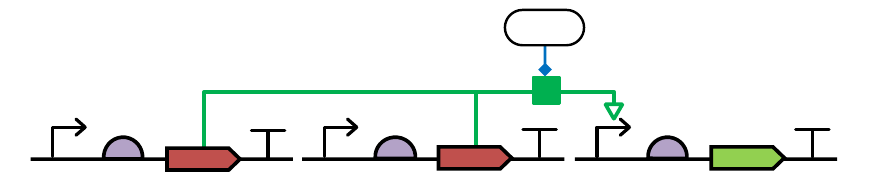
Figure 41: Phosphorylation of an inactive transcription factor (produced by two different CDSs) by a kinase to form an active transcriptional activator, which then stimulates a promoter.